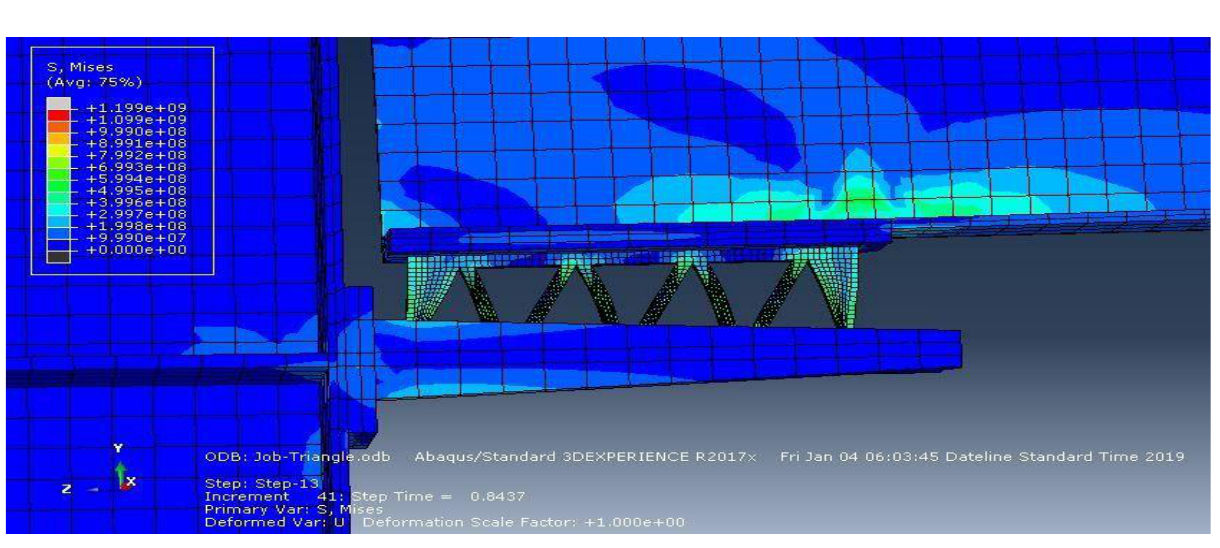
Figure 6. The shape of the triangular slit damper after applied load in Abaqus software Plastic deformation on the vertical struts of the slit dampers dissipates the energy, as illustrated in Fig 6. with different fill-up data of moment versus rotation for two distinct shapes of slit dampers with the same area of roundness. It has been shown that changing the shape of the slit damper from cubic